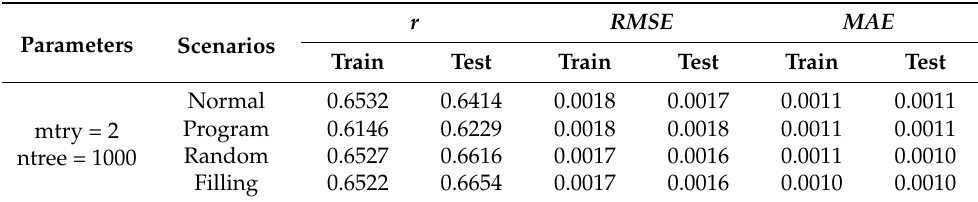
Table 4. RF model prediction performances in four